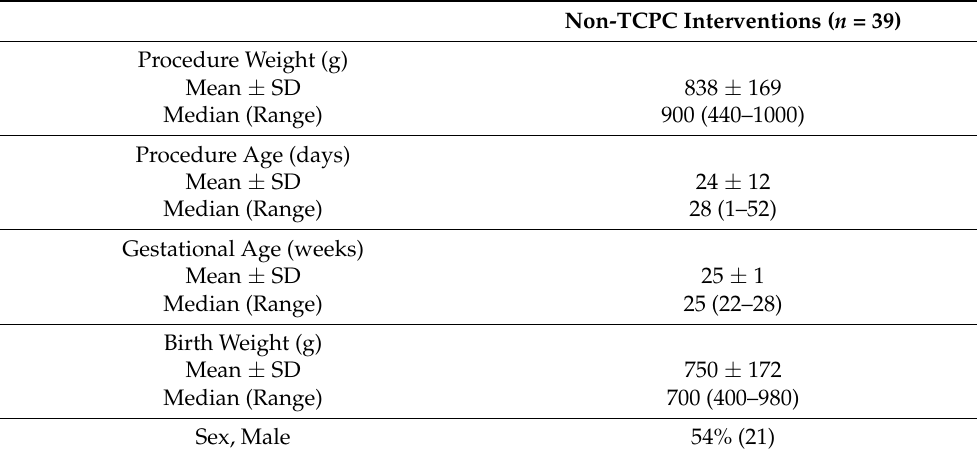
Table 2. Demographics and Baseline